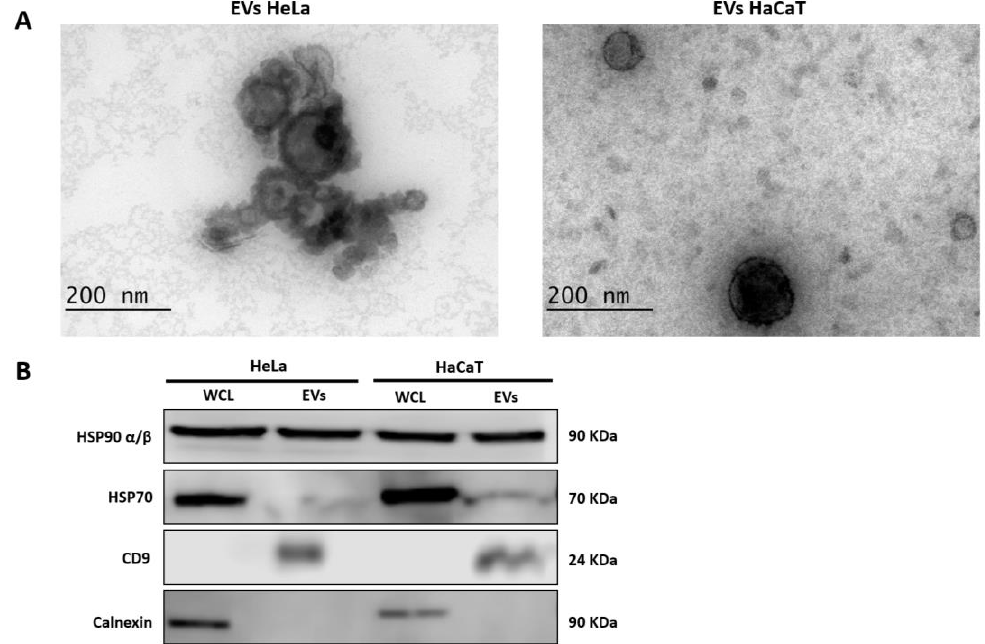
Figure 1. Characterization of EVs derived from HeLa and HaCaT cells: ( A ) visualization of EVs using TEM (×200,000); ( B ) Western blot analysis of EV markers HSP90 α/β, HSP70, and CD9. Calnexin protein was used as a marker of EV purity. EVs: extracellular vesicles; WCL: whole-cell lysate.